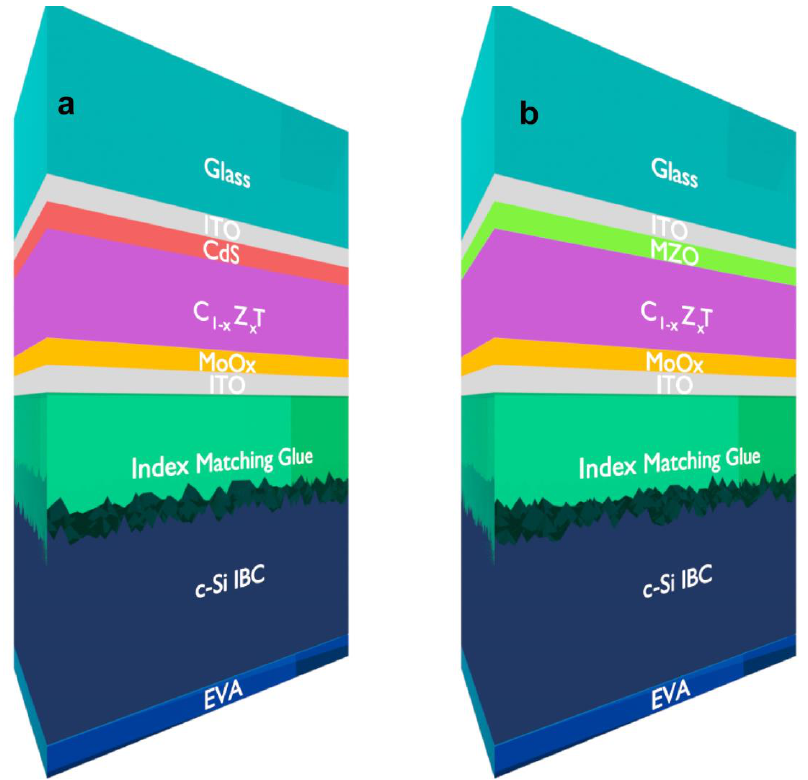
/ c-Si interdigitated back contact (IBC) tandem cells with top cell Figure 2 Figure 2. Schematic of C 1 − x Z x T